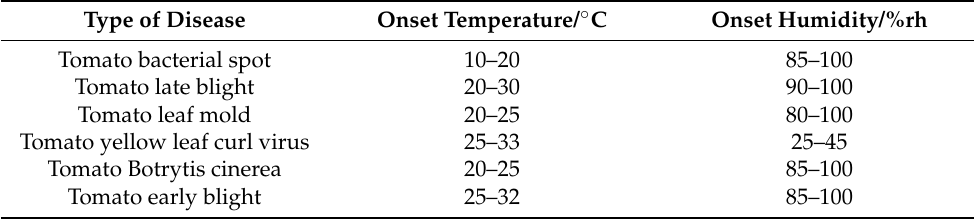
Figure 1. Example of Tomato Diseased Leaf Data Set. ( a ) Tomato leaf image — simple background image taken in the laboratory, 256 × 256 pixels. The image types include Tomato Leaf mold, Tomato Late night, Tomato normal leaves, Tomato Vertical spot, Tomato Yellow leaf curl virus. ( b ) Tomato leaf image — complex background image taken in greenhouse, 3024 × 3024 pixel. Image types include Tomato Leaf mold, Tomato Late blind, Tomato normal leaves, Tomato Botrytis cinerea, and Tomato Early blind. Table 1. The relationship between disease, temperature and